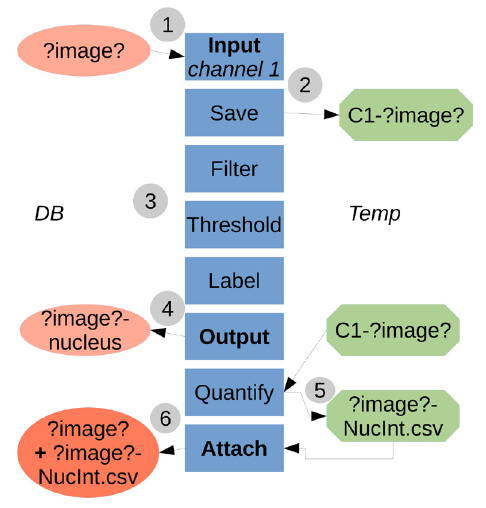
Figure 1. Flowchart of the TAPAS system. 1 ) The data to be processed is input into the processing pipeline from the Database (either OMERO or local). ?image? is a keyword used to refer to the image name. The names in boxes refer to the